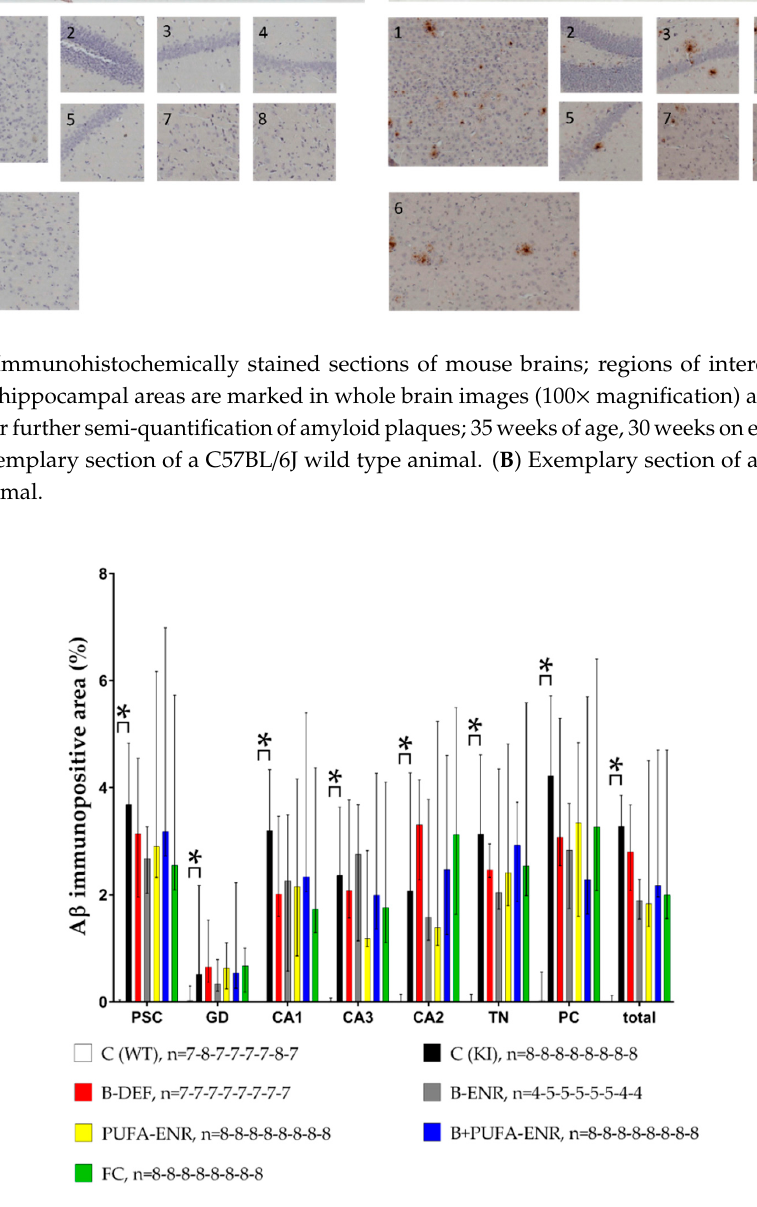
Figure 11. Semi-quantitative analysis of amyloid- β (A β ) in immunohistochemically stained brain sections; results are shown for single regions of interest (ROI) and in total; 35 weeks of age, 30 weeks on experimental diet (males and females pooled); data presented as median ± IQR; outliers beyond threefold IQR removed; p < 0.05 (Mann-Whitney-U-test) considered statistically significant (*).